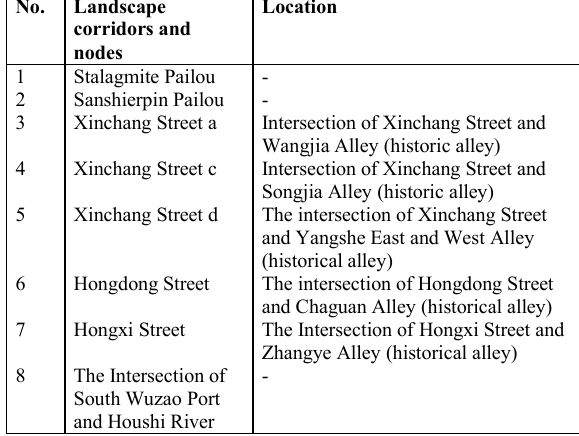
Figure 9 . The 270 ° viewshed from Diyilou Bookstore (yellow points).